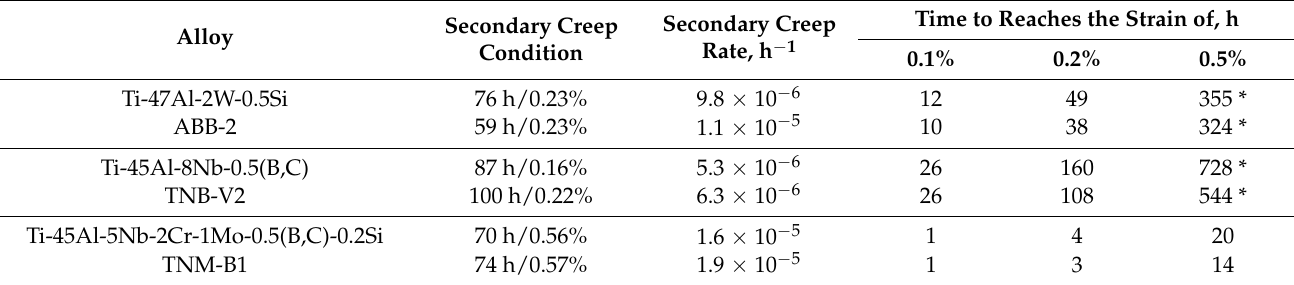
Table 4. Results of creep test of produced and reference